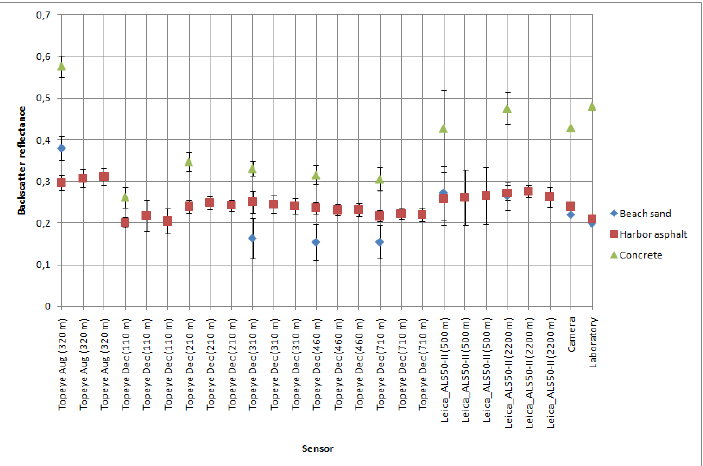
Figure 8B. Backscatter reflectance values of natural samples using parking lot asphalt as reference target. Standard deviation of the walkway is marked with red as the largest one. Backscatter reflectance for beach sand, harbor asphalt and